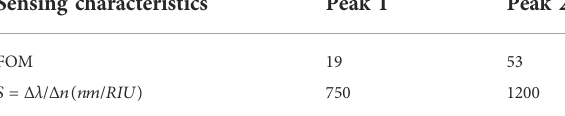
TABLE 2 RI sensing characteristics.